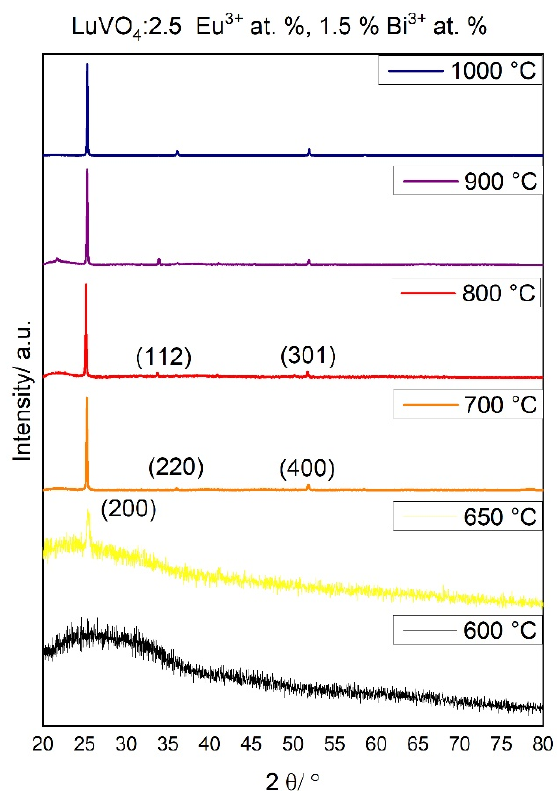
Figure 3. S tructural evolution of LuVO 4 : 2.5% at. Eu 3+ , 1.5% at. Bi 3+ films by XRD analysis. Figure 3. Structural evolution of LuVO 4 : 2.5% at. Eu 3+ , 1.5% at. Bi 3+ films by XRD